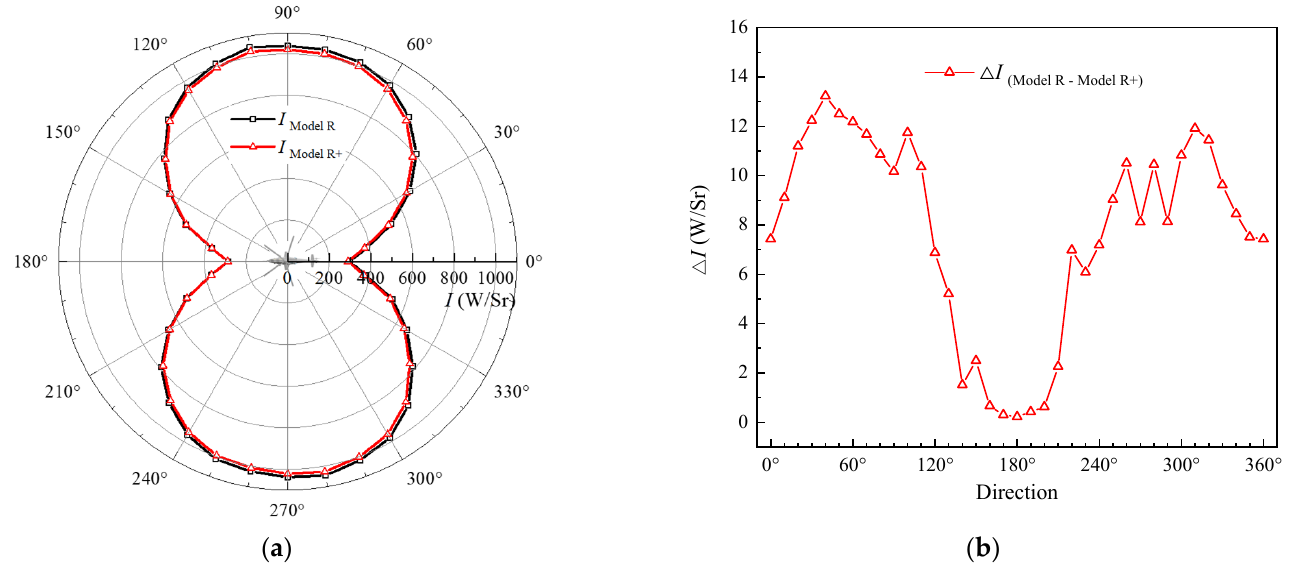
Figure 20. Installation position of the de fl ectors. ( a ) Left view; and ( b ) free view.